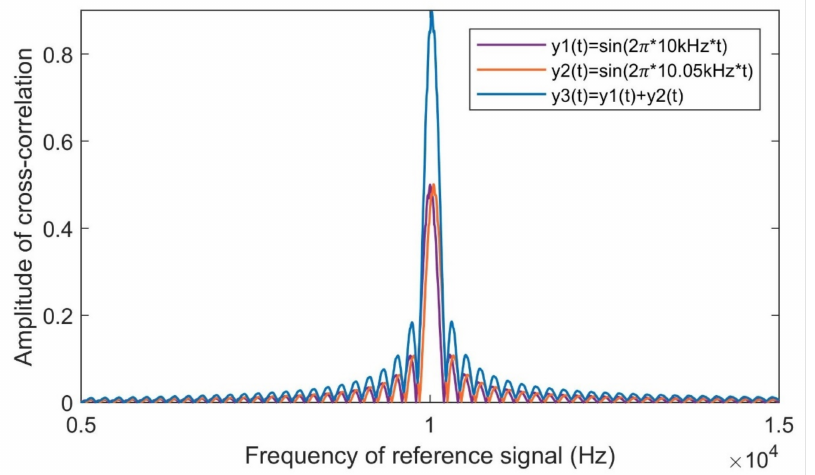
Figure 4. Cross-correlation spectra of the sinus signals and their sum.